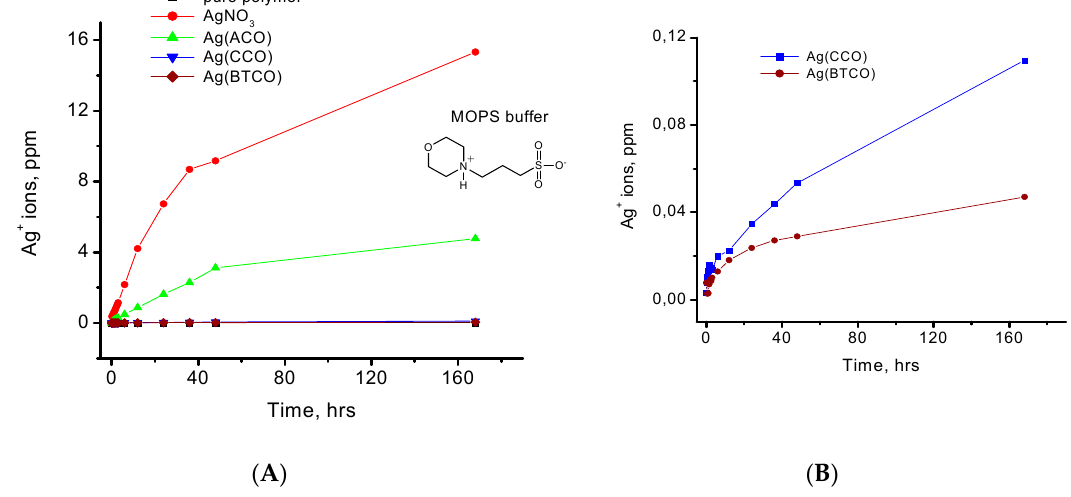
Figure 4. ( A) Results of Silver(I) ions leaching experiment carried out for the acrylate polymeric composite (used as control) and with different Ag-compounds. Data obtained in aqueous solution at room temperature using the non-halogenated MOPS buffer at pH~7; ( B) Replotted in detail the lowest time traces for two Ag-cyanoximates that were undistinguishable in panel A .